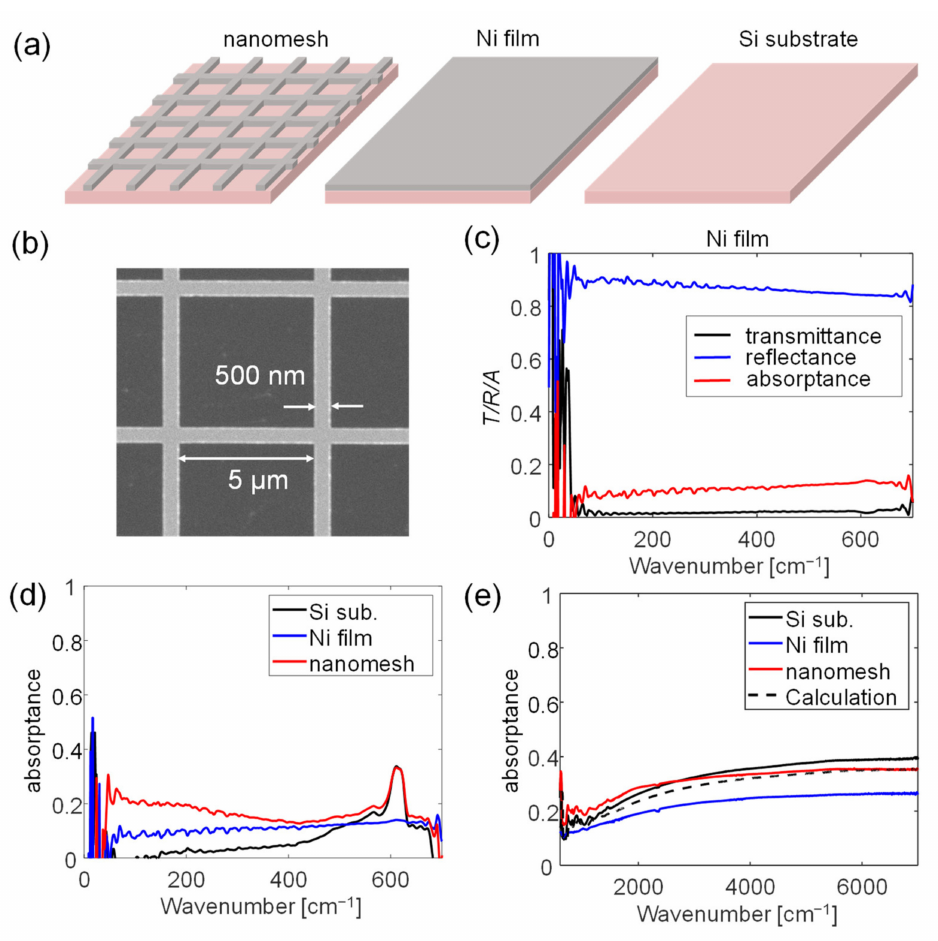
Figure 6. ( a ) Schematic diagrams of a nanomesh absorber, an Ni metal film, and a high-resistivity Si substrate. ( b ) An SEM image of the fabricated nanomesh sample with square holes in the mesh. The size of the square holes was 5 µ m × 5 µ m, the linewidth of the mesh was 500 nm, and the thickness of the Ni film was ~15 nm. ( c ) The measured spectra of the Ni film in the far-infrared range (60–600 cm − 1 ). The measured transmission ( T ) and reflection ( R ) spectra are shown by the black and blue curves, respectively, and the red curve plots the absorptance A as calculated by A = 1 − T − R . ( d ) The measured far-infrared absorptance of the highly resistive substrate, the Ni film, and the nanomesh sample are plotted as the black, blue, and red curves, respectively. ( e ) The light absorptance of the substrate, Ni film, and nanomesh samples in the middle-infrared band (1000–7000 cm − 1 ), shown by the black, blue, and red solid curves, respectively. The black dashed curve shows the combined absorptance calculated by using Equation